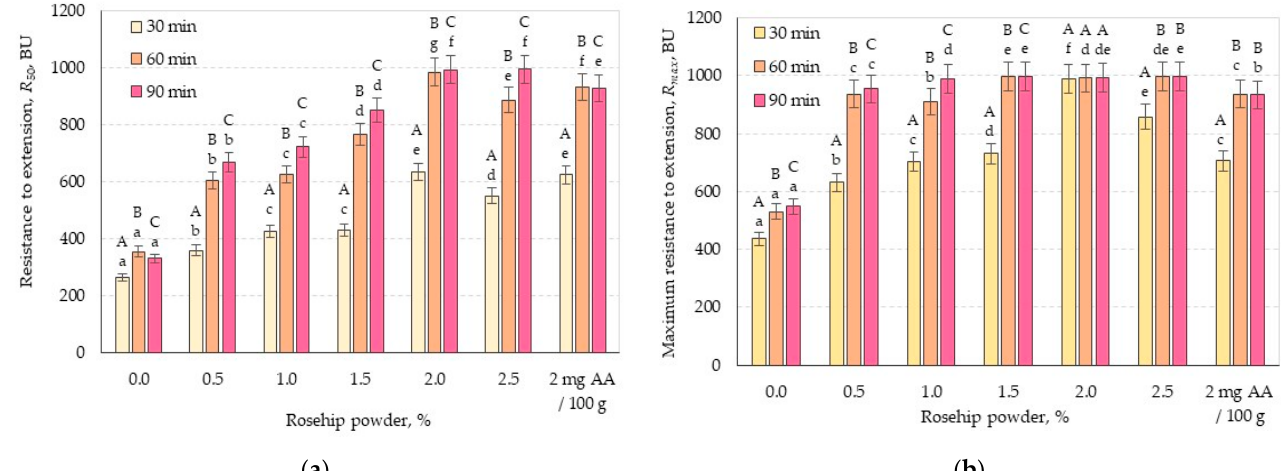
Figure 1. Resistance to extension as a function of Rp addition: ( a ) Resistance to extension at 50 mm ( R 50 ); ( b ) Maximum resistance to extension ( R max ). Di ff erent capital le tt ers represent statistically different mean values ( p ≤ 0.01) of each sample for di ff erent times (30, 60, and 90 min). Di ff erent lower-case le tt ers are responses statistically di ff erent ( p ≤ 0.01) of all samples for each time (30, 60, and 90 min). BU—Brabender Units, AA—ascorbic acid.